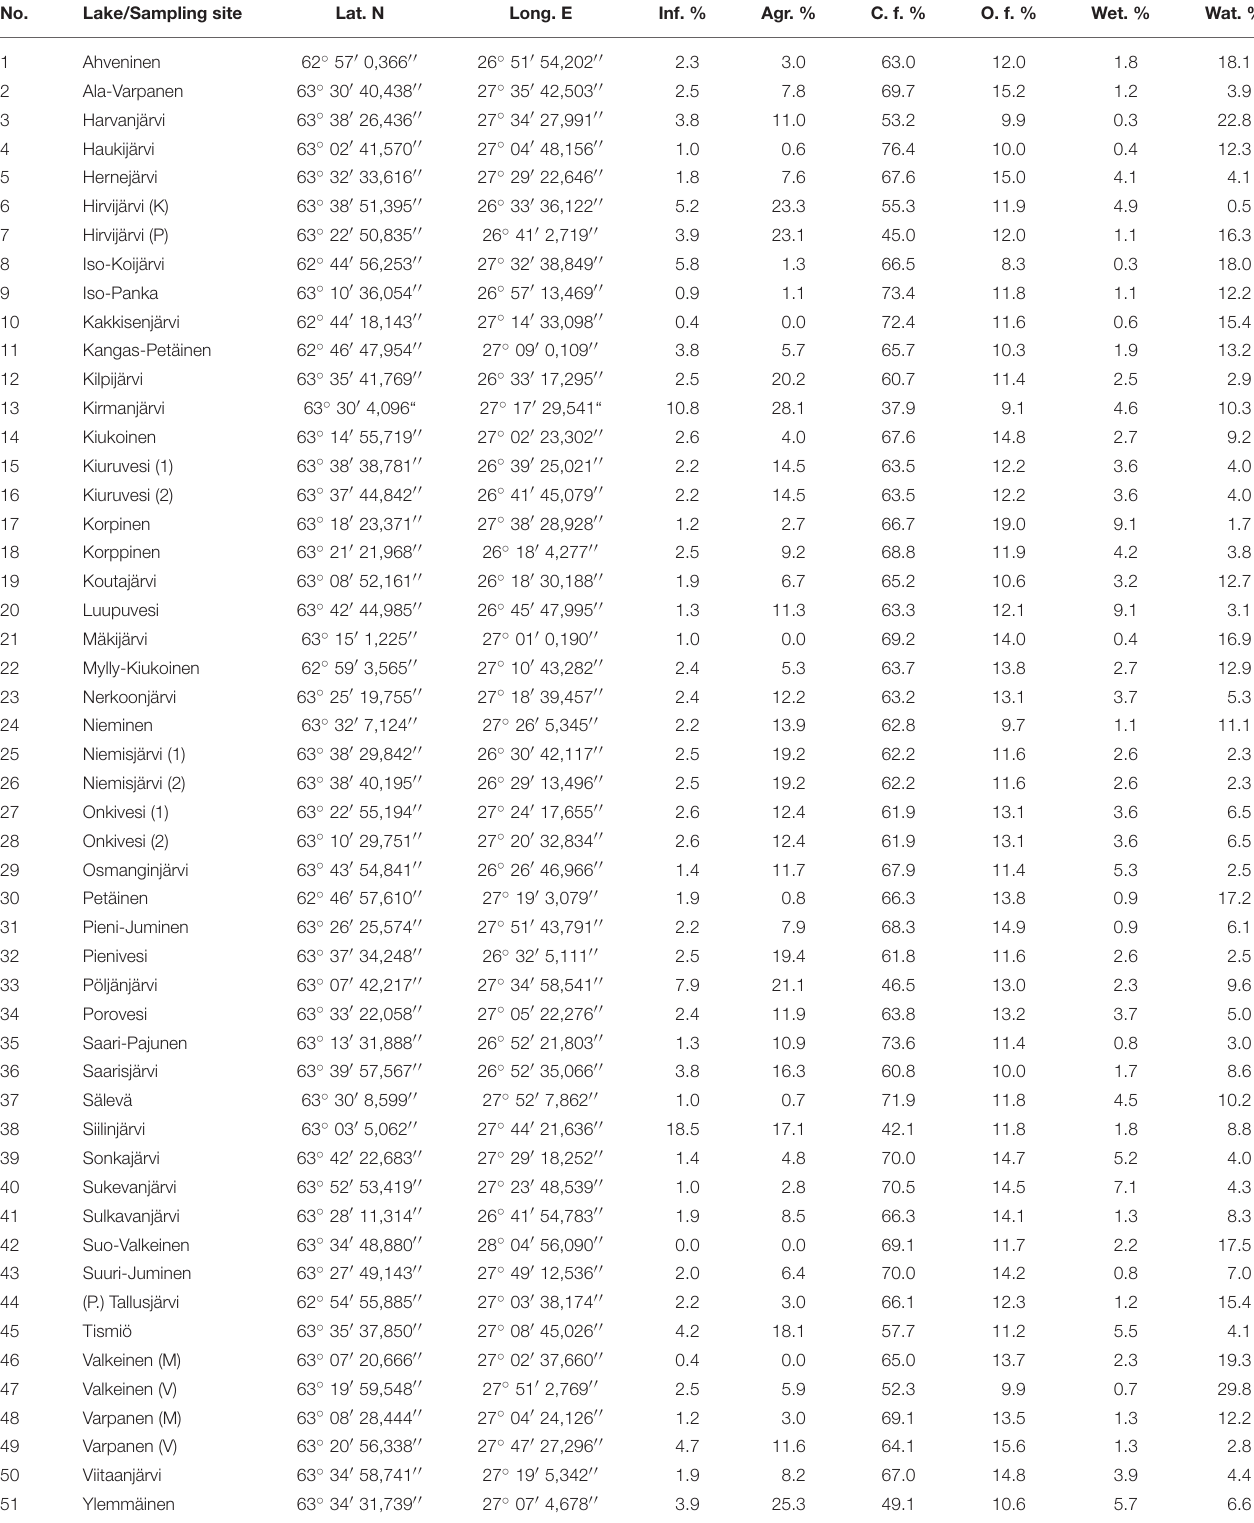
TABLE 1 | Coordinates for the sampling sites and modern land use of the lake catchments (Finnish Environment Institute, 2014b) including infrastructure, agriculture, closed and open forests, wetlands, and water.